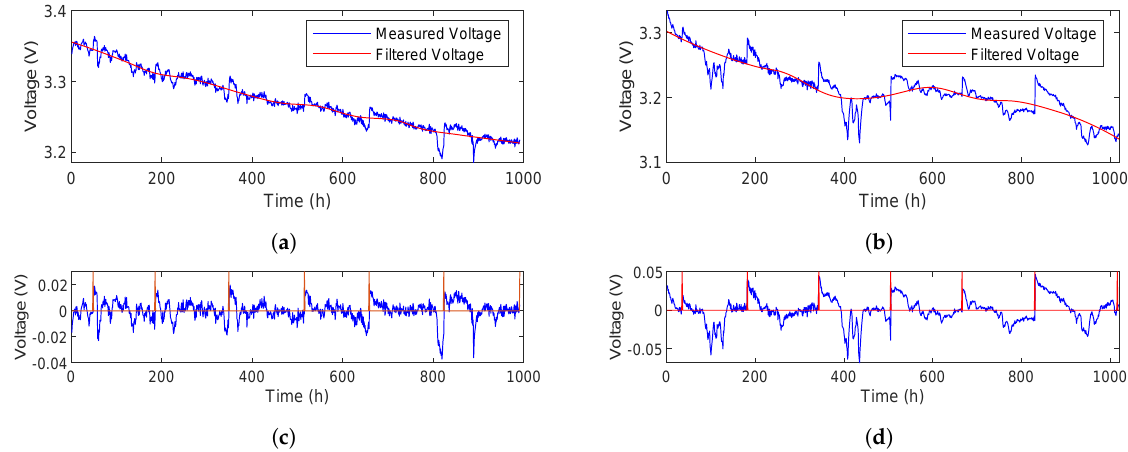
Figure 6. Voltage decomposition result. ( a ) Calendar aging voltage of FC1; ( b ) calendar aging voltage of FC2; ( c ) reversible aging voltage of FC1; ( d ) reversible aging voltage of